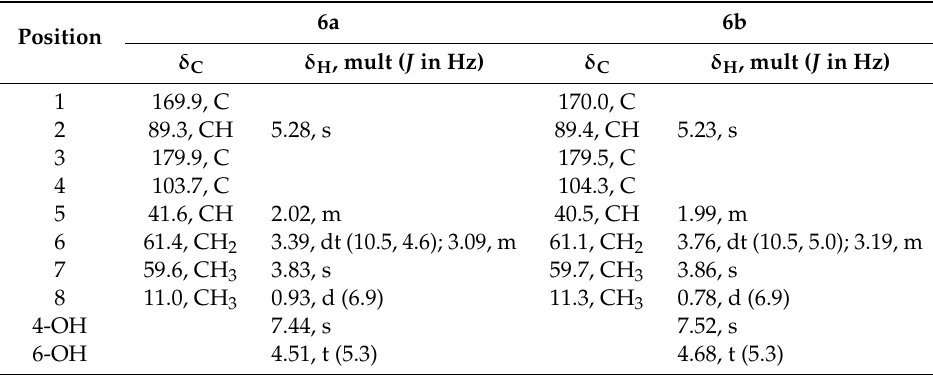
Table 3. 1 H (400 MHz) and 13 C (100 MHz) NMR data for 6a and 6b in DMSO- d 6 . Position